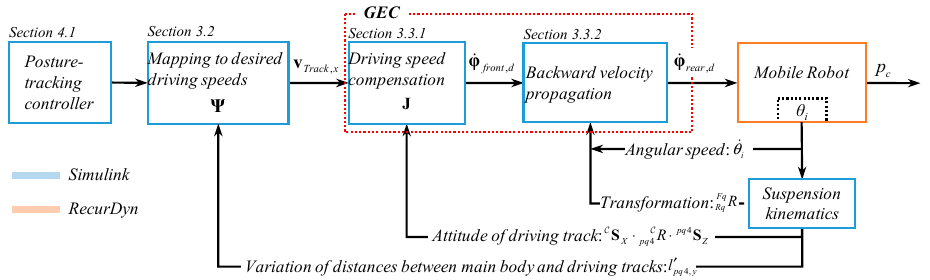
Figure 4. Detailed block diagram of the posture tracking control strategy of the proposed MR including the GEC with backward velocity propagation and feedbacks from the suspension kinematics. For each driving track, the track angular speed 𝜑(cid:4662) (cid:3043)(cid:3044) for the desired 𝑣 (cid:3043)(cid:3044),(cid:3051)𝒞 can be calculated through following Equation (9) considering the track-terrain contact angle (TTCA) relative to the frame {𝒞} .